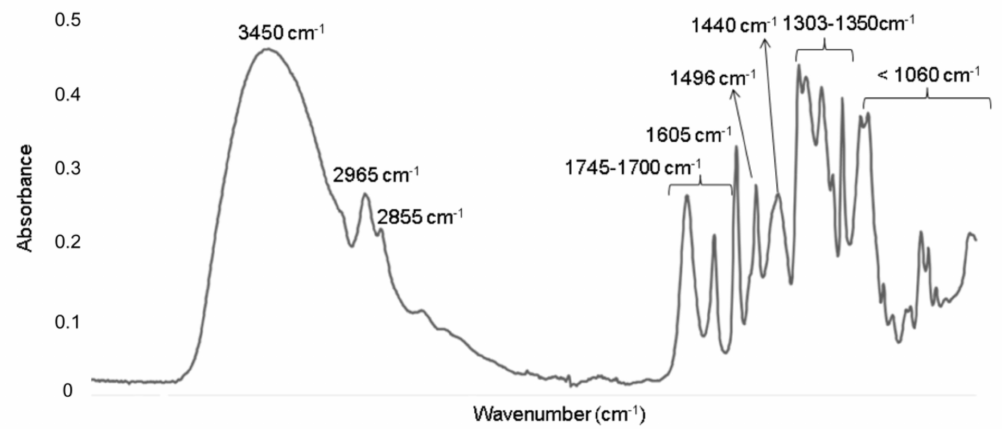
Figure 2. FTIR spectrum obtained for